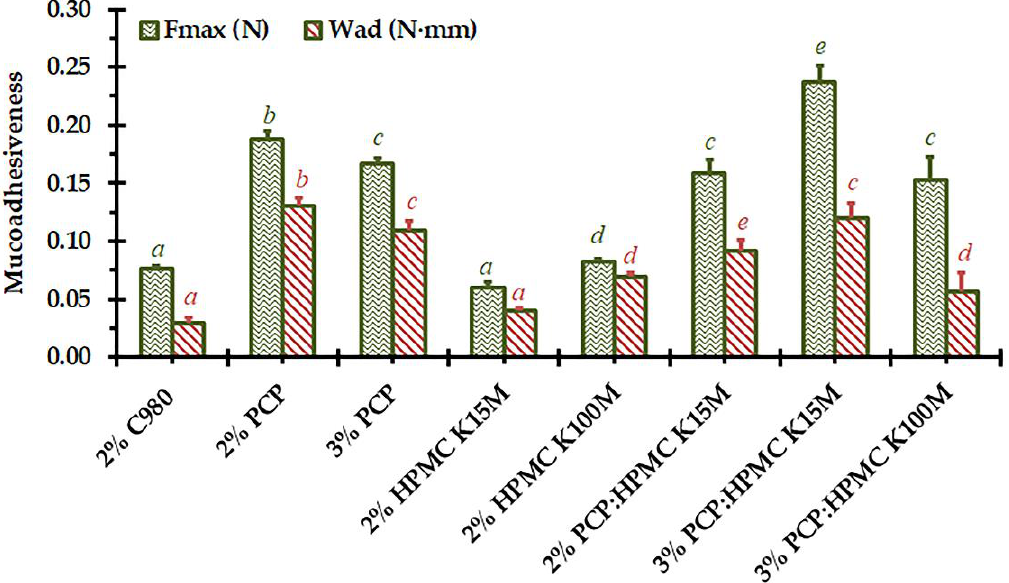
Figure 5. Mucoadhesiveness, in terms of maximum detachment force ( F max , N) and work of adhesion ( W ad , N · mm), of C. comosa mucoadhesive gels. Means of six determinations ( ± SD) values with different superscript letters are significantly different ( p < 0.05, one-way ANOVA followed by Tukey’s post hoc multiple comparisons).